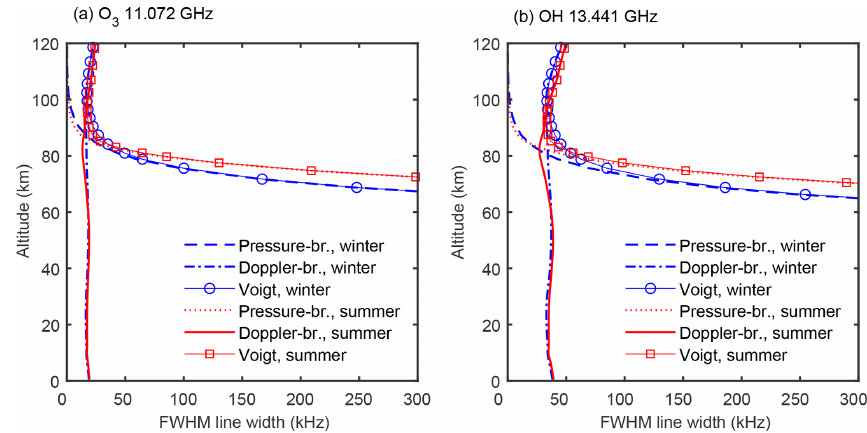
Figure 4. Pressure-broadened, Doppler-broadened, and Voigt full-width half-maxima (FWHM) line widths for (a) ozone (O 3 ) 11.072GHz and (b) OH 13.441GHz emission lines, calculated for mean winter (DJF) and mean summer (JJA) conditions at Kilpisjärvi (69 ◦ 03 (cid:48) N, 20 ◦ 48 (cid:48) E),